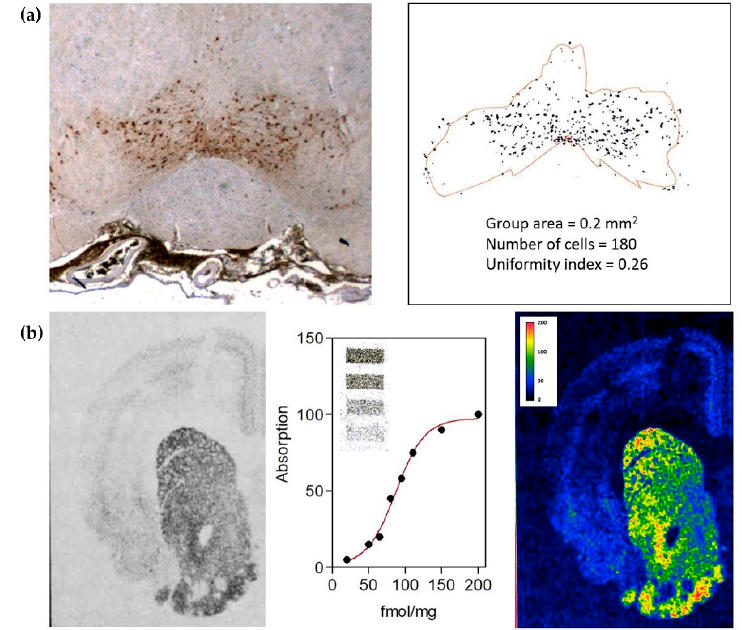
Figure 1. ( a ) Computer-assisted image analysis of a transmitter-identified nerve cell group. Dopaminergic cells in the rat ventral tegmental area are shown in the left panel. Automatic image analysis methods (see [29]) can be used to discriminate cell profiles and to estimate the tissue area populated by the cell group (contour line) in order to evaluate parameters characterizing the size of the cell group and the distribution of the cells in that area. ( b ) Computer-assisted image analysis of receptors. Dopamine receptor distribution in rat striatum (left panel) as visualized by in situ 3H-spiperone binding and autoradiography (see [35,36]). Image intensities can be calibrated in terms of the amount of binding by using standards of known concentrations of the ligand (middle panel). Thus, both the overall distribution and the number of receptors in the different regions of the tissue can be evaluated (right panel).